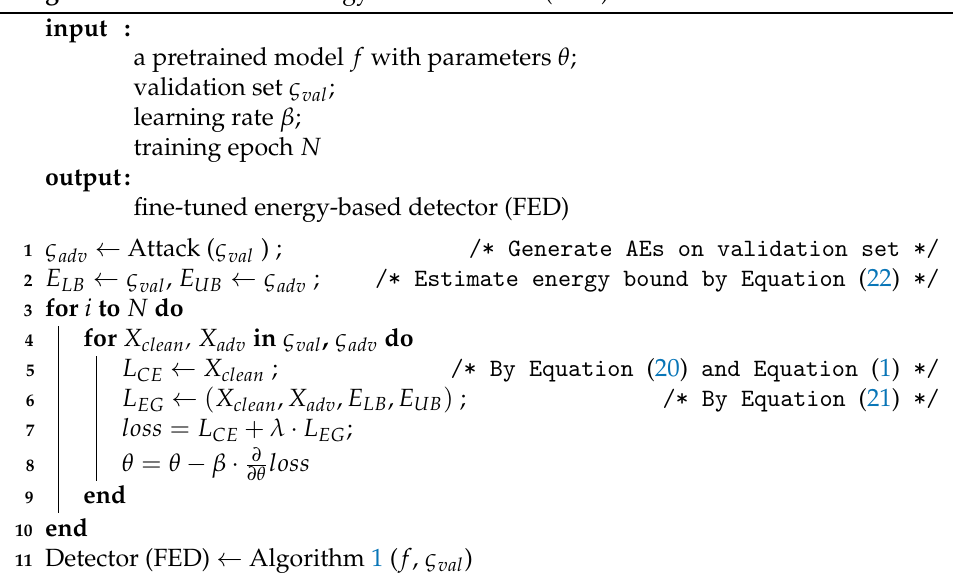
Algorithm 2: Fine-tuned energy-based detector